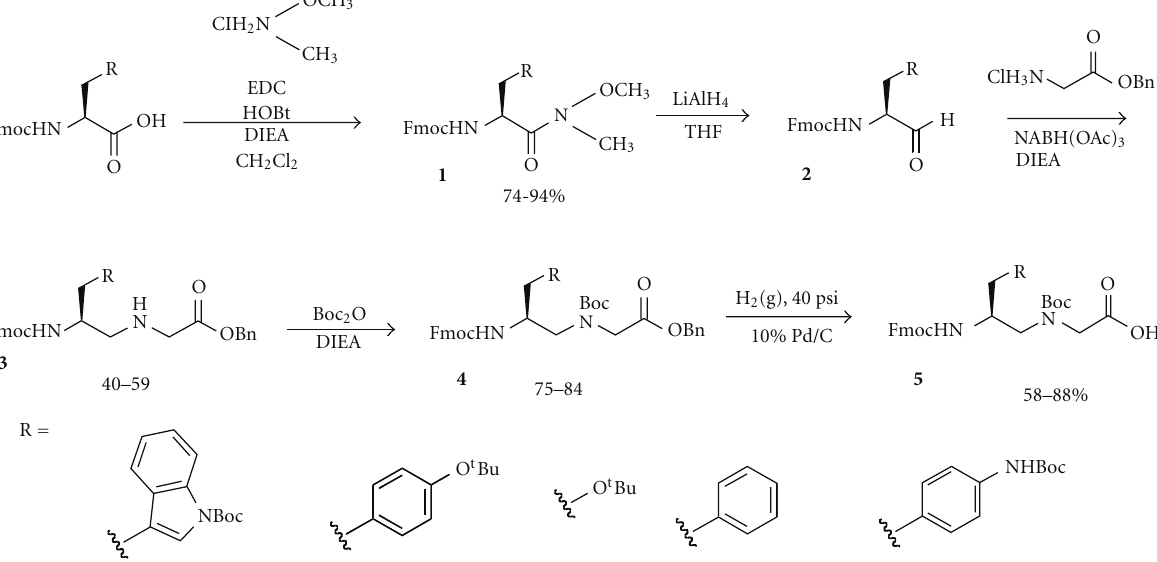
Scheme 1: Synthesis of PAA monomers.